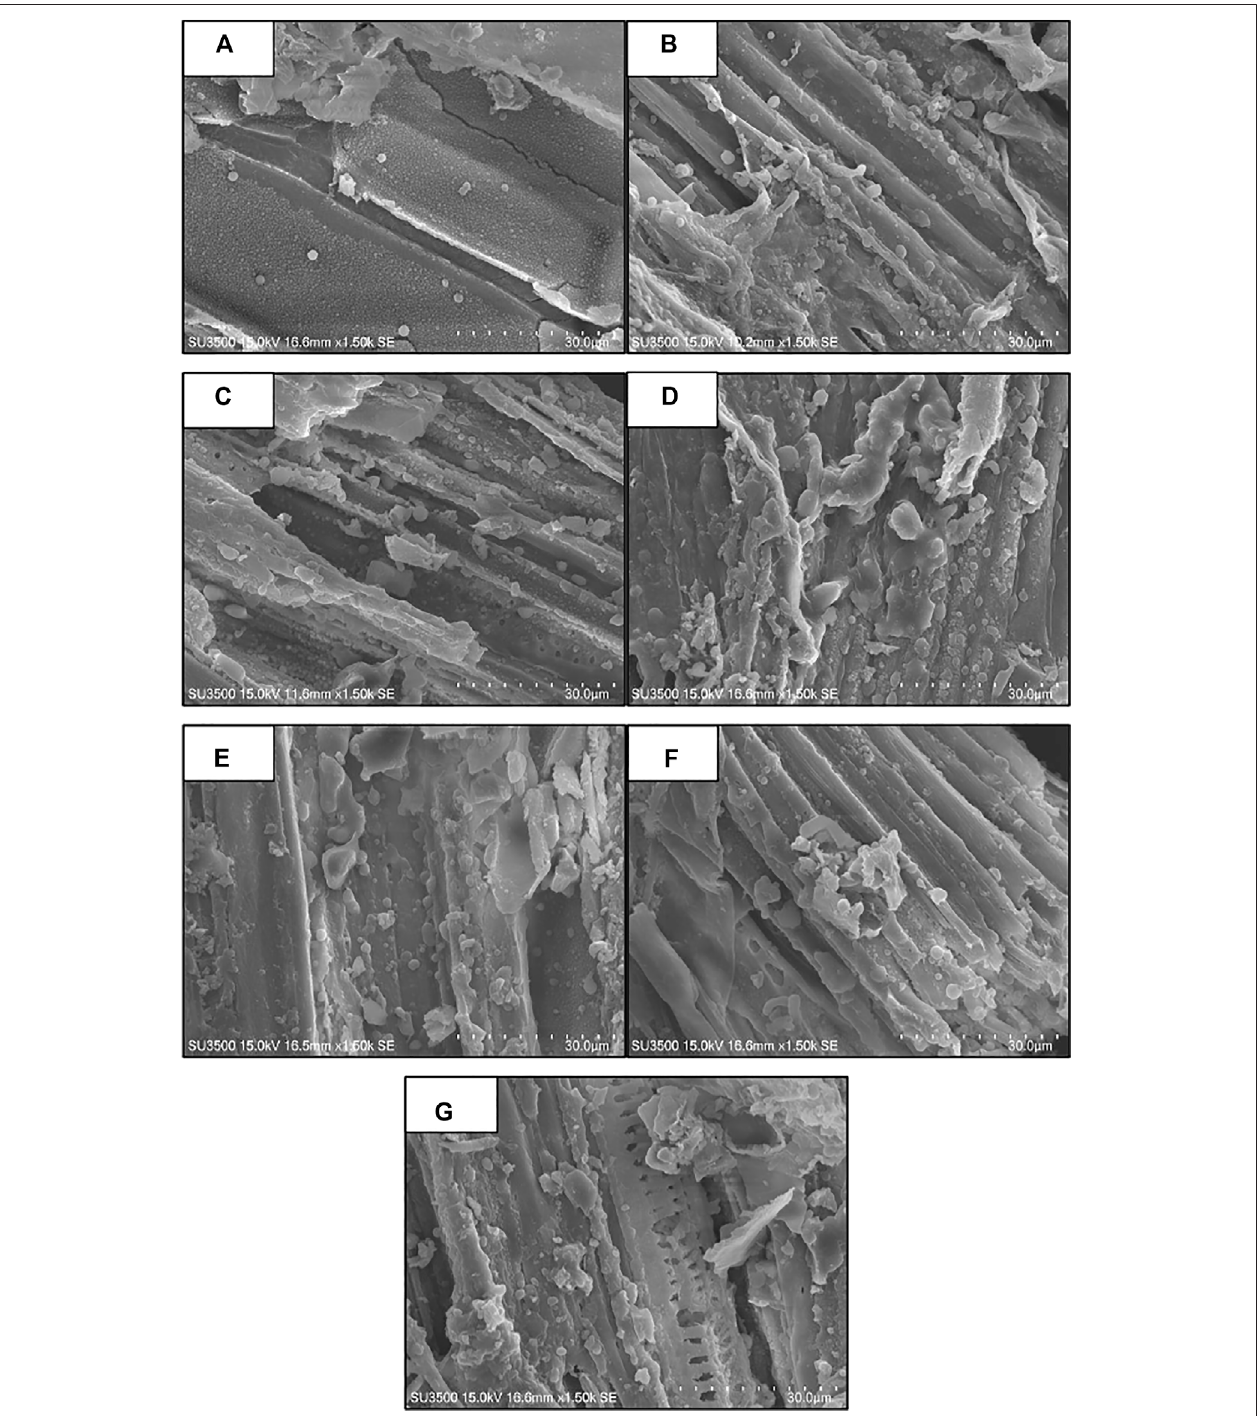
FIGURE5| Contrastanalysisdiagramsofsurfacemicrostructuresofwheatstrawandhydrochar[ (A) HTC-PWR0hydrochar, (B) HTC-PWR1hydrochar, (C) HTC- PWR2 hydrochar, (D) HTC-PWR3 hydrochar, (E) HTC-PWR4 hydrochar, (F) HTC-PWR5 hydrochar, (G) HTC-PWR6 hydrochar].